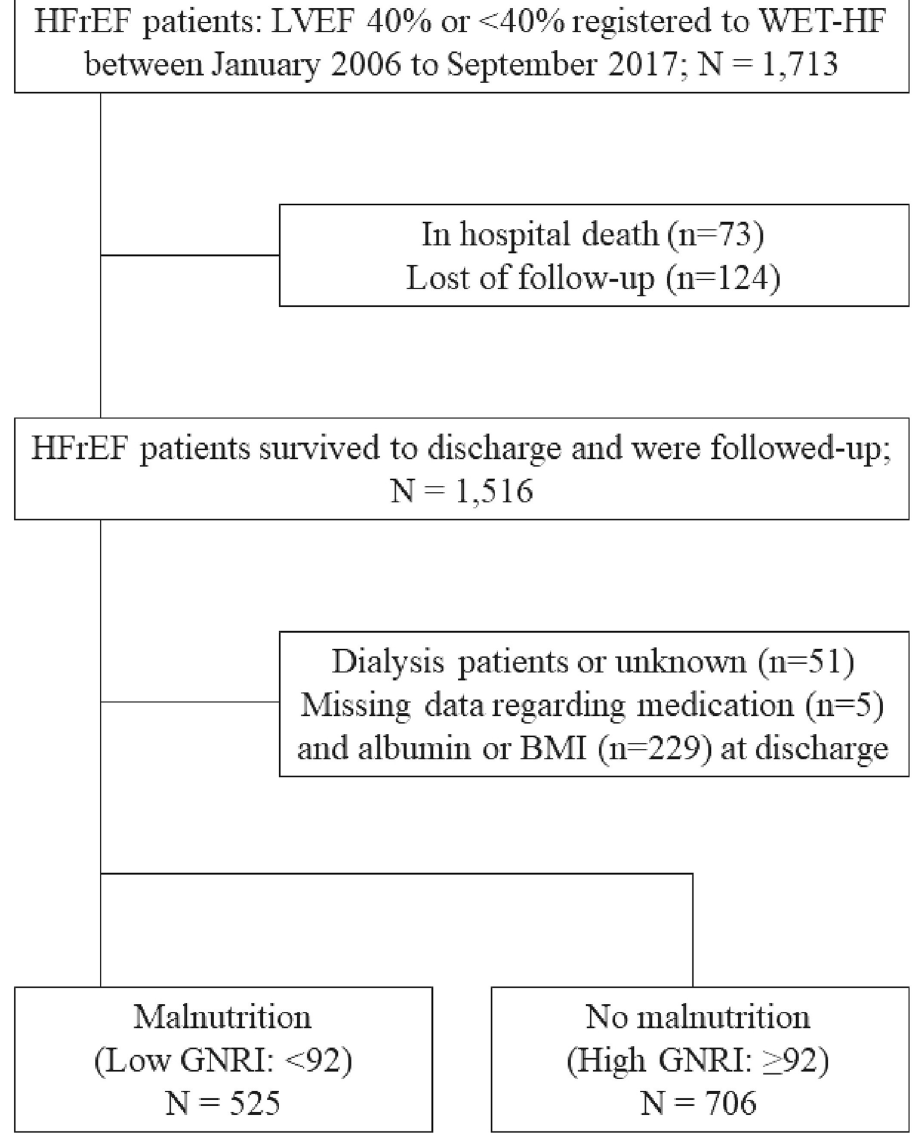
Figure 1. Study flowchart. The HFrEF patients were categorized according to their GNRI score into groups with malnutrition (low GNRI) or normal nutritional status (high GNRI). HFrEF heart failure with reduced ejection fraction, WET-HF West Tokyo Heart Failure, GNRI geriatric nutritional risk